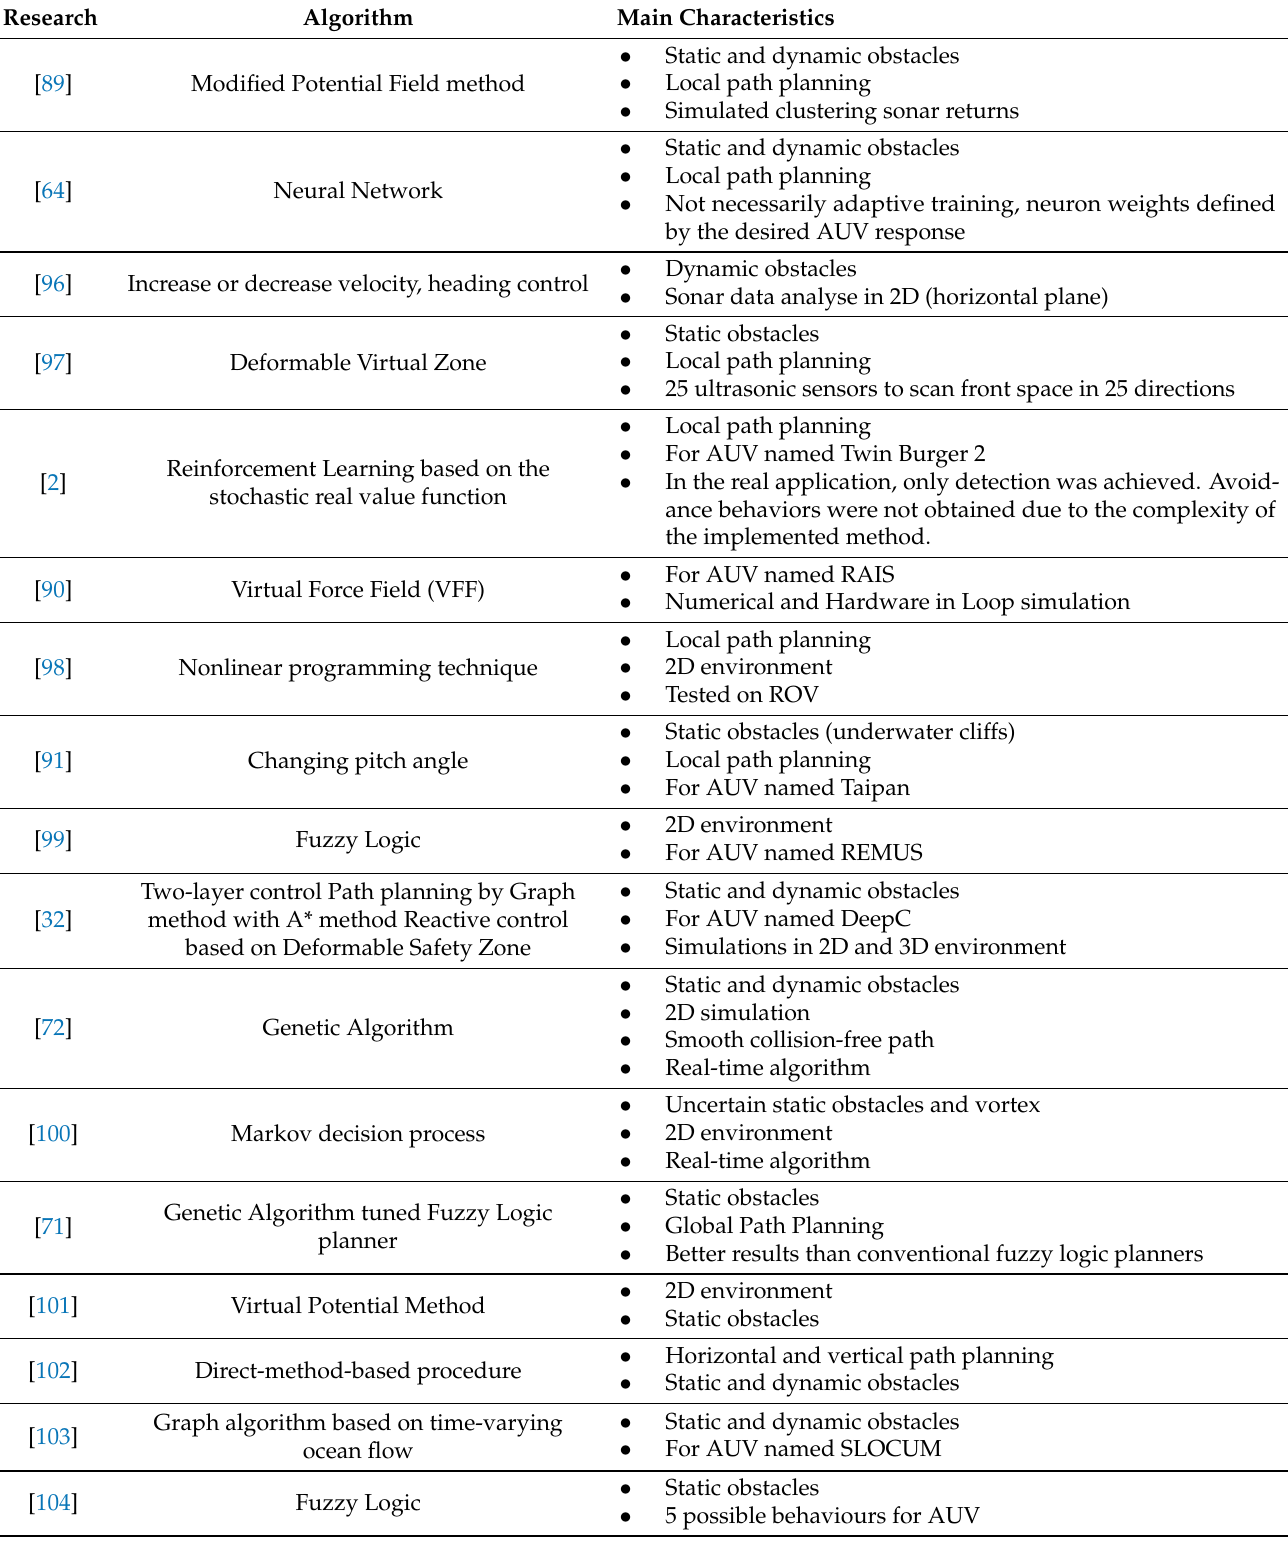
Table 2. List of algorithms validated in numerical research until